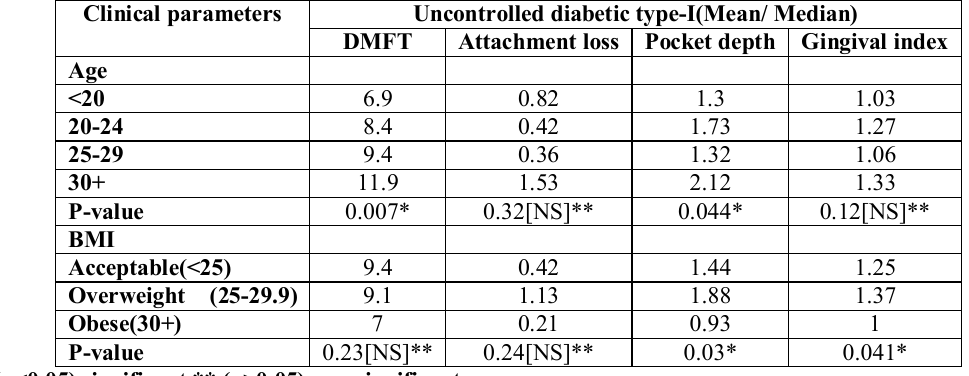
Table 3: the difference in average (mean/median) of oral health status parameter between age and BMI categories among uncontrolled diabetic type-I